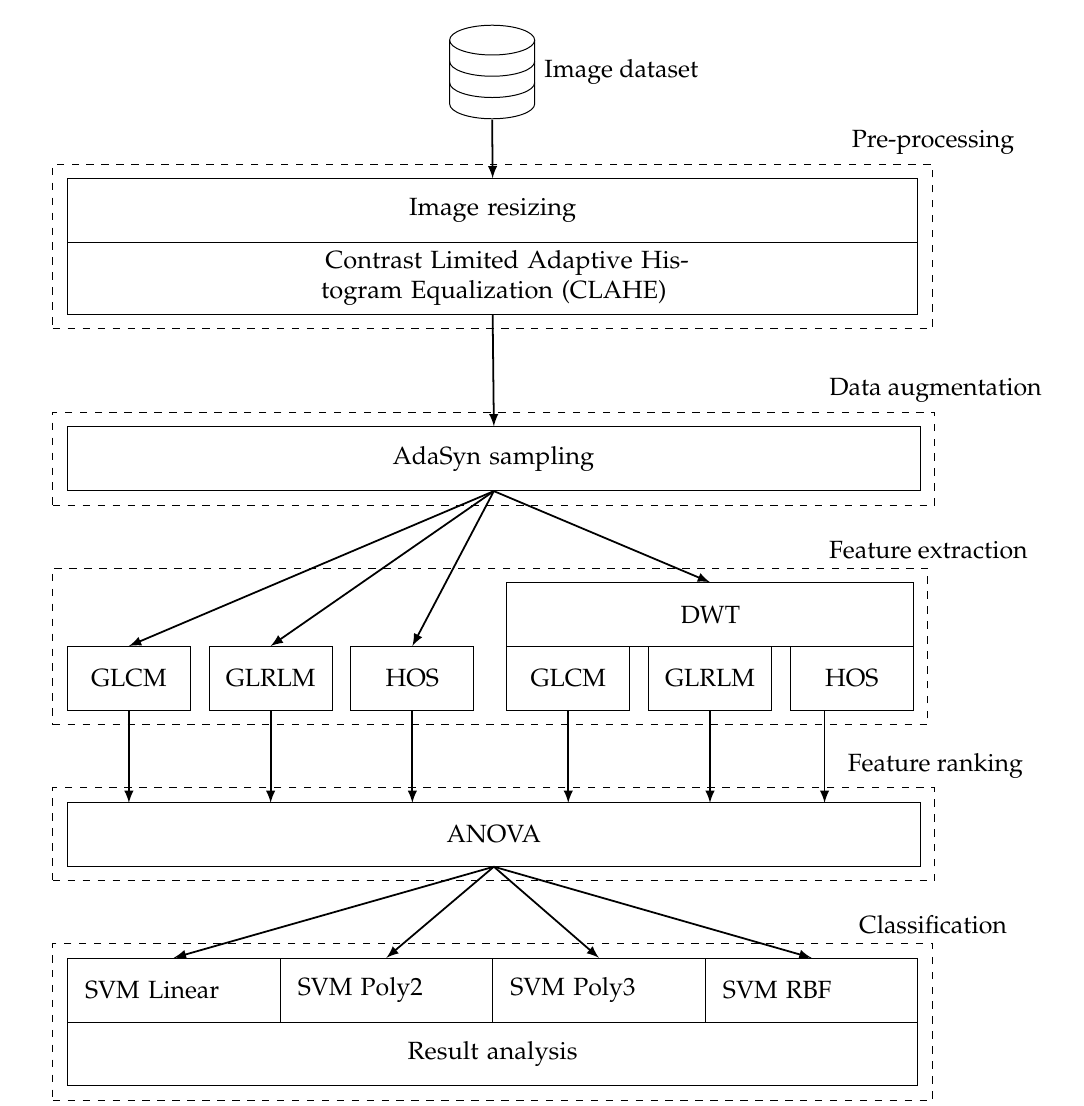
Figure 1. Overview block